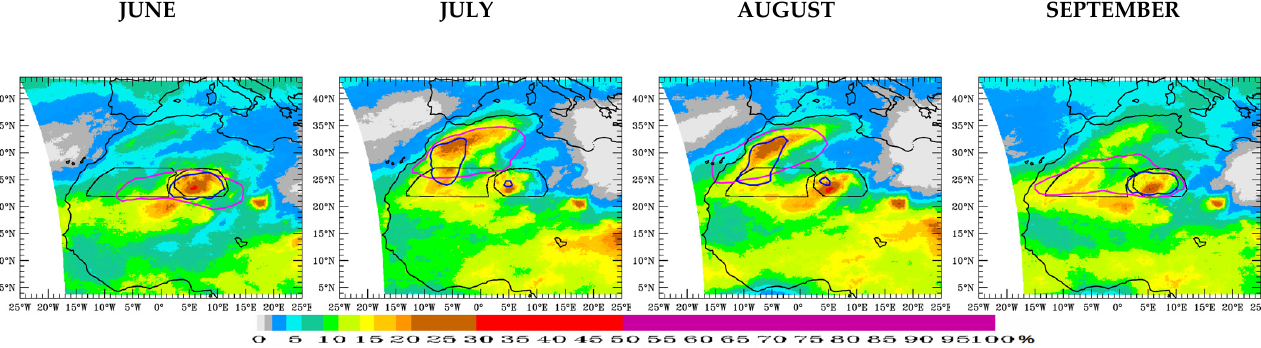
Figure 3. Mid-top COF (shadings), boundaries of the most frequent region for the Saharan anticyclone (SAC, pink contour) and most frequent region for the Saharan heat low (SHL, red contour).